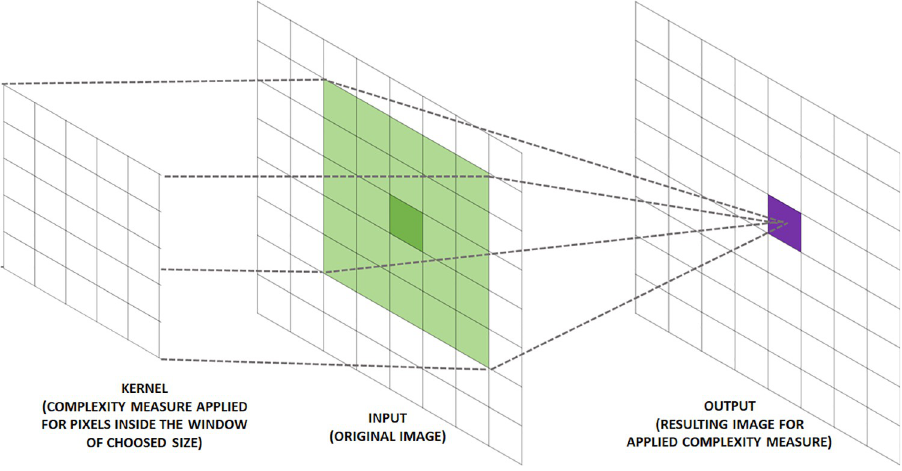
Fig 6. Operation of CompPlex Janus